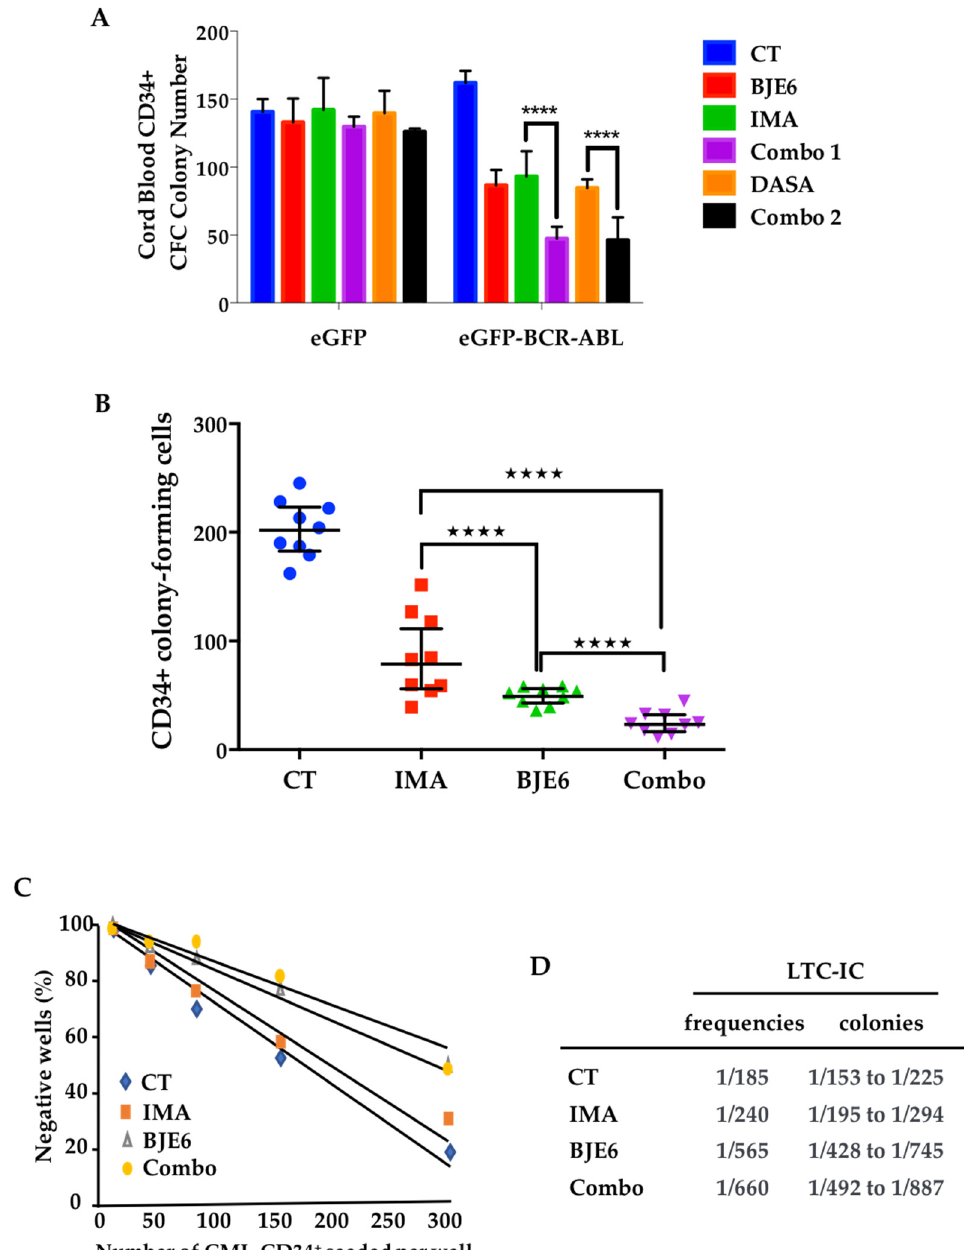
Figure 5. PKC δ inhibition affects CML stem cells. ( A ) Cord blood CD34 + cells were transduced with a lentiviral vector expressing BCR-ABL (eGFP-BCR-ABL) or not (eGFP) and incubated for 48 h with DMSO (CT), 0.1 µM BJE6, 1 µM IMA, 2 nM DASA, or a combination of BJE6 and IMA (Combo 1)